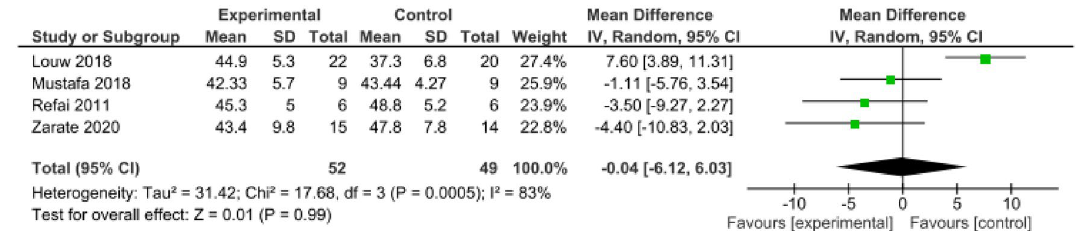
Figure 4. Dextrose versus Placebo injections for maximum incisor opening at 12